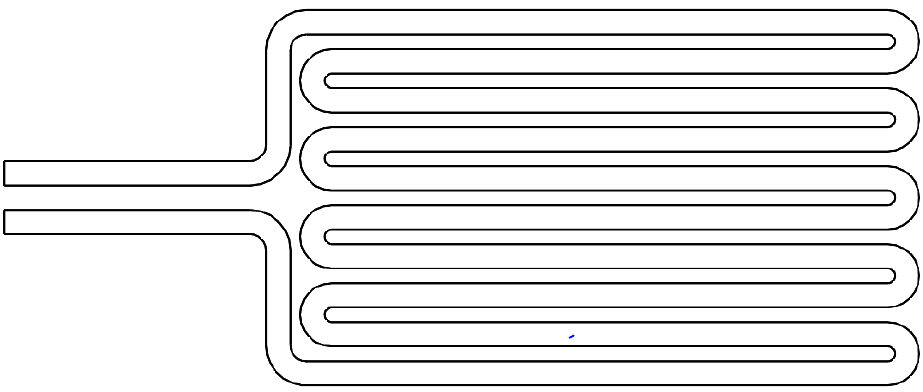
Figure A11. Fabric Design LP-3. Lengthwise pass design, woven conductive polyester fabric.